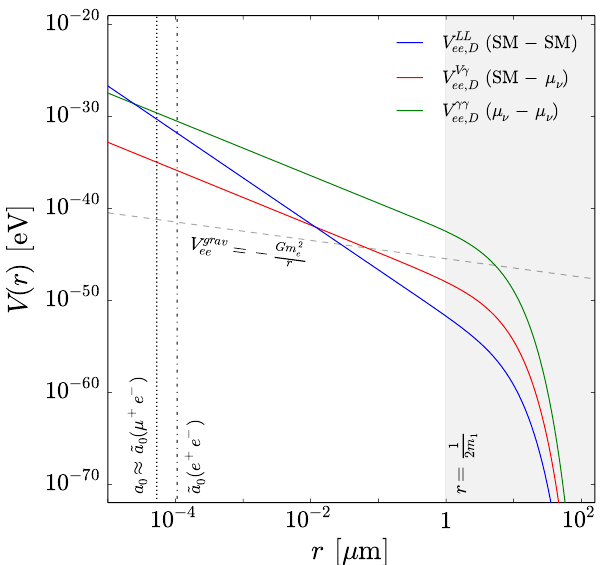
Figure 6 . Neutrino-mediated potentials V V (cid:13) plotted for positronium ( e (cid:0) e + ) with the exchange of either three light active Dirac neutrinos with m 1 = 0 : 1 eV and NO mixing parameters and using (cid:22) ij (cid:17) (cid:22) (cid:23) = 10 (cid:0) 12 (cid:22) B . These potentials are compared with the gravitational potential V grav